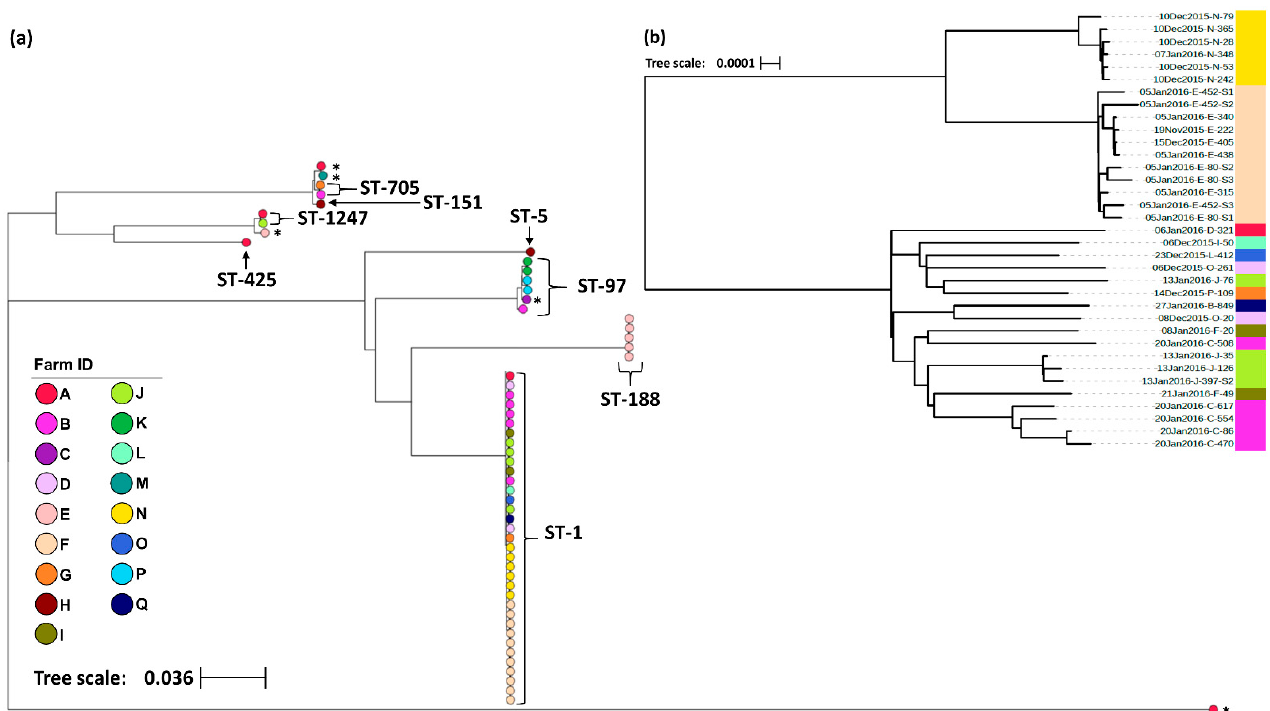
Figure 2. ( a ) Maximum-likelihood phylogeny generated from core single nucleotide polymorphisms across the 57 S. aureus isolates. All isolates were collected from bovine raw milk samples in New Zealand and have been labelled with their sequence type (ST) as identified by seven MLST genes. Those isolates with an asterisk (*) indicate isolates whose ST remained undetermined. ( b ) Maximum-likelihood phylogeny generated from core single nucleotide polymorphisms across the 35 S. aureus ST-1 isolates identified in ( a ). Isolate IDs identify the date the sample was collected (dd/mm/yyyy), the farm from which it was collected from (A–Q), and the animal ID number. In both trees, the color of the terminal tree nodes also corresponds to the farm from which the isolate was collected. Both figures were created using the online tool Microreact